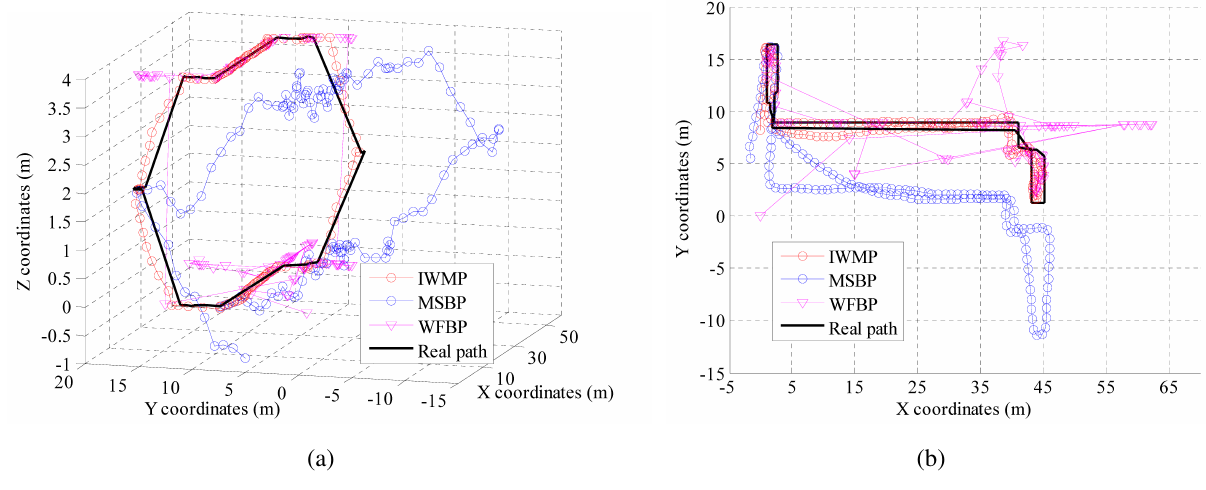
Figure 11. Results of positioning in the x-y-z plane and the x-y plane. ( a ) Results